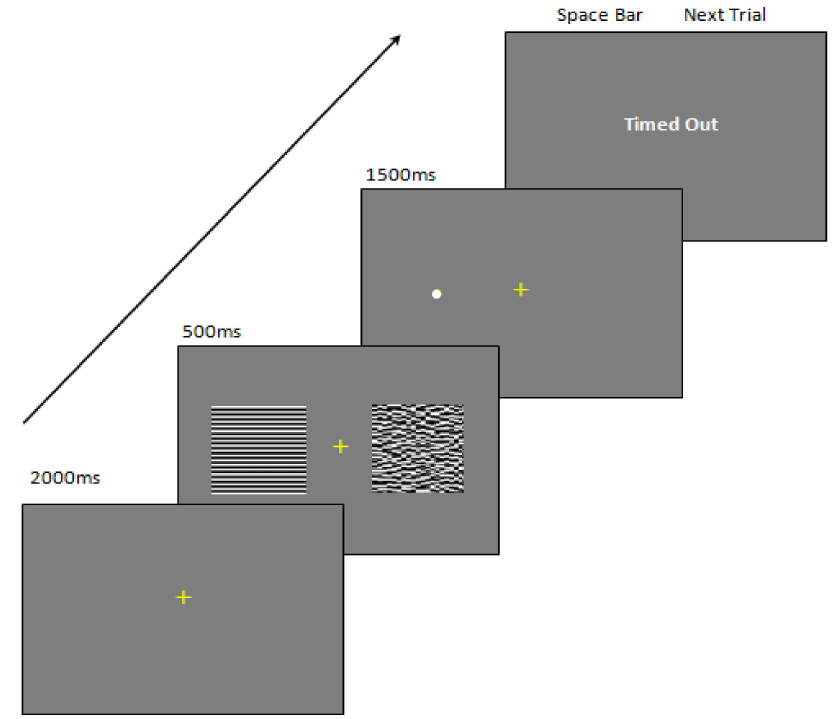
Figure 2. Achromatic dot-probe trial for a stimulus pair of left: 3 cpd, right: scrambled 3 cpd. In the chromatic condition, both stimuli were overlain with one of ten colours matched from Wilkin’s Intuitive Overlays. The pair of stimuli appear for 500 ms side by side. Immediately after, a dot appeared, either on the left or right, centred on the location previously occupied by either stimulus, and participants responded left or right as quickly as possible corresponding to the location of the